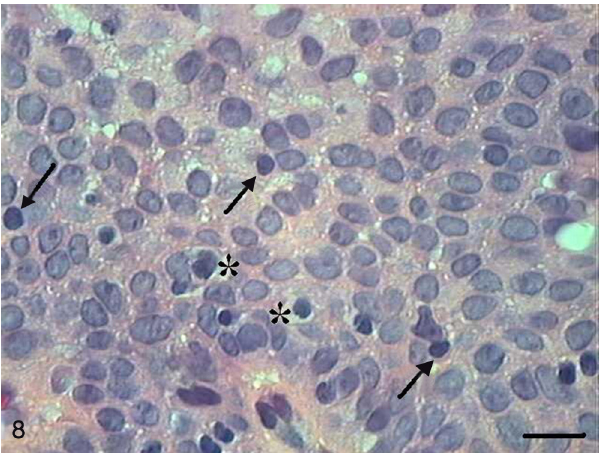
Figure 8 Papilloma. Micrograph of papilloma with cell apo- ptosis with condensation of cytoplasm (arrows) and anoikis (*) Figure 10 Grade II squamous carcinoma cells with AgNORs. (HE, bar = 10 (cid:2) m). Micrograph of grade II squamous cell carcinoma containing AgNORs forming rounded clumps filling the entire nucleolus or as Medians of apoptotic indexes. small satellites scattered by the nucleus (AgNOR, bar = 10 (cid:2) m). AgNORs per field compared with SCC II ( p < 0.0001) and III ( p < 0.0001). Likewise, SCC II showed a lower mean of total AgNORs per field compared to SCC III ( p < 0.0001)